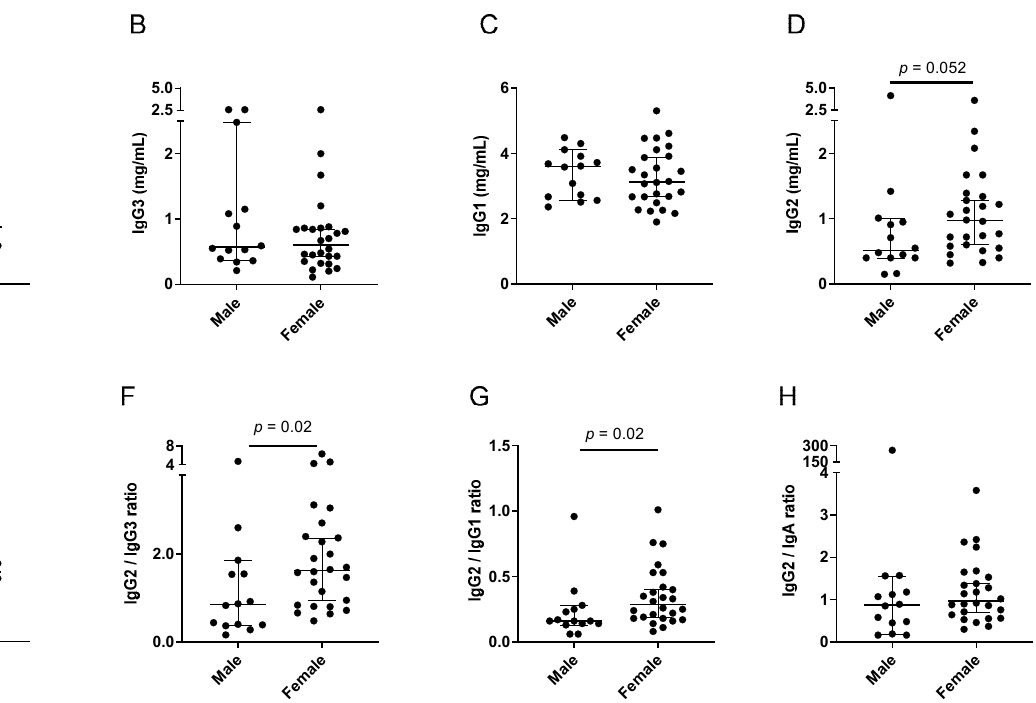
Figure 7. Isotype profiles in females and males within the FluVIT study. Each symbol represents a different participant. Group medians are shown with 95% CI. p values from Mann–Whitney tests are shown when p ≤ 0.10. Individual isotypes ( A – E ) and ratios ( F – H ) are shown. Table 7. Higher preference for IgG2 in females compared to males in the FluVIT human study.